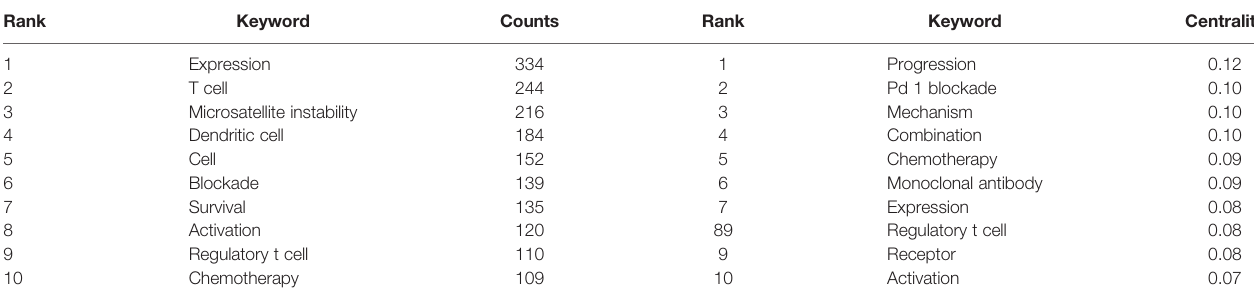
TABLE 8 | The top 10 most frequent and centralized keywords related to colorectal cancer